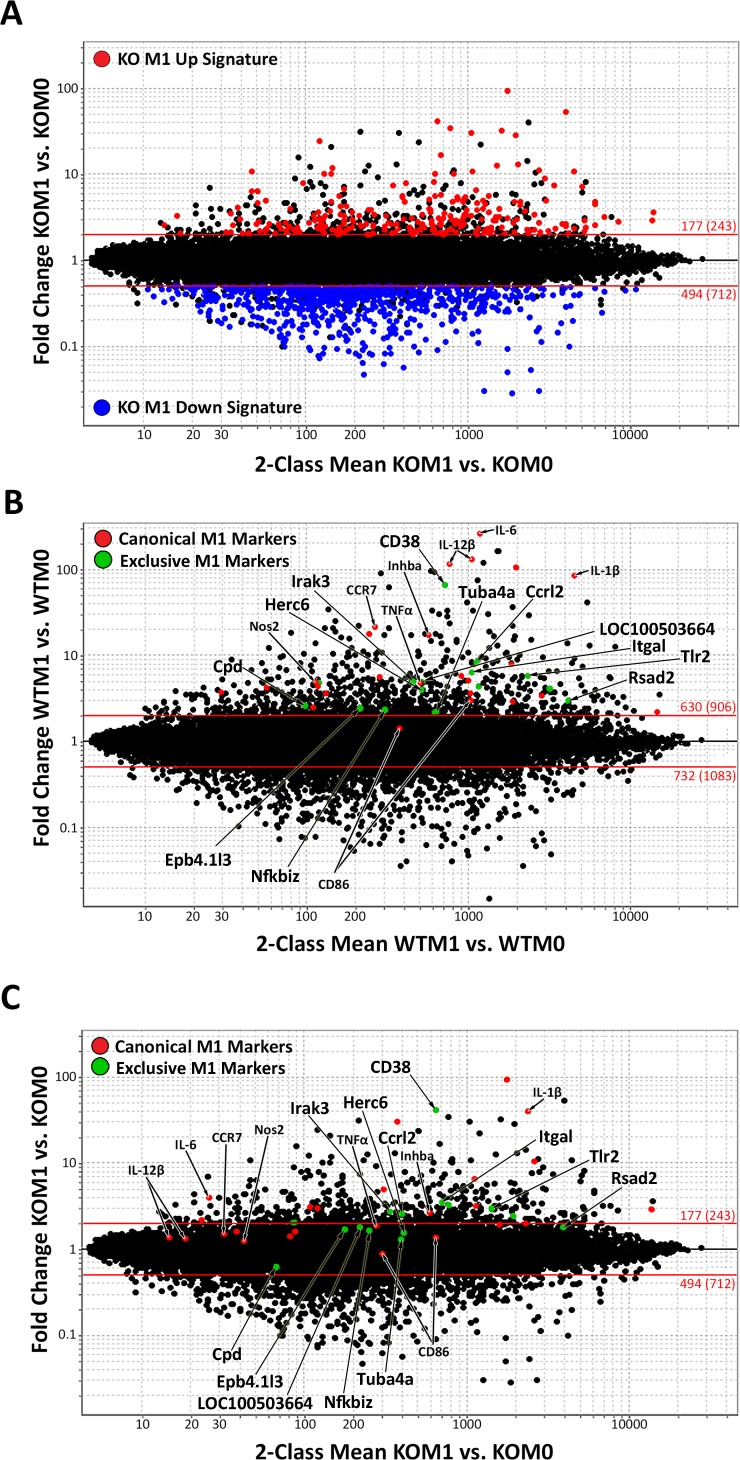
Classically activated macrophage signature in wild-type and miR-155 knockout macrophages.Fold Change (FC) vs. Mean Expression Value (MEV) plot of microarray data highlighting 2 FC or higher up-regulated genes (red, p≤0.05) or down-regulated genes (blue, p≤0.05) in (A) knockout (KO) M1 to M0 macrophages comparison (n = 3). (B, C) FC vs. MEV plot with previously described classical M1 markers highlighted (in red) and the top 15 M1-exclusive genes (identified in [17]) most decreased in KO M1 macrophages (in green) in the WT M1 vs. M0 comparison (B) and the KO M1 vs. M0 comparison (C). Red lines represent a +/- 2FC cut-off.